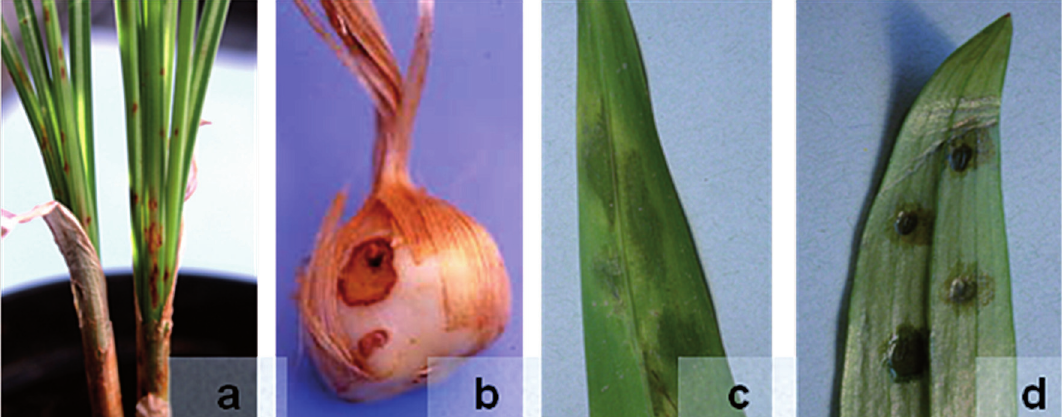
Figure 2. Symptoms of bacterial softrot in an experimentally infected saffron plant and corm (a and b), and on gladi- olus (c) and lily (d)